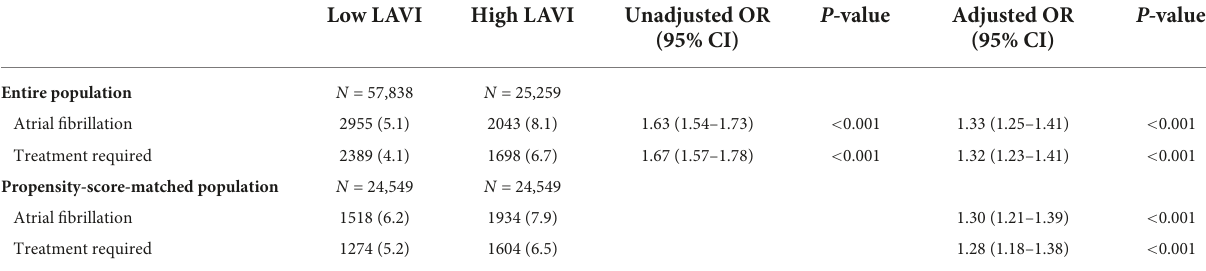
TABLE 3 Incidence of postoperative atrial fibrillation.